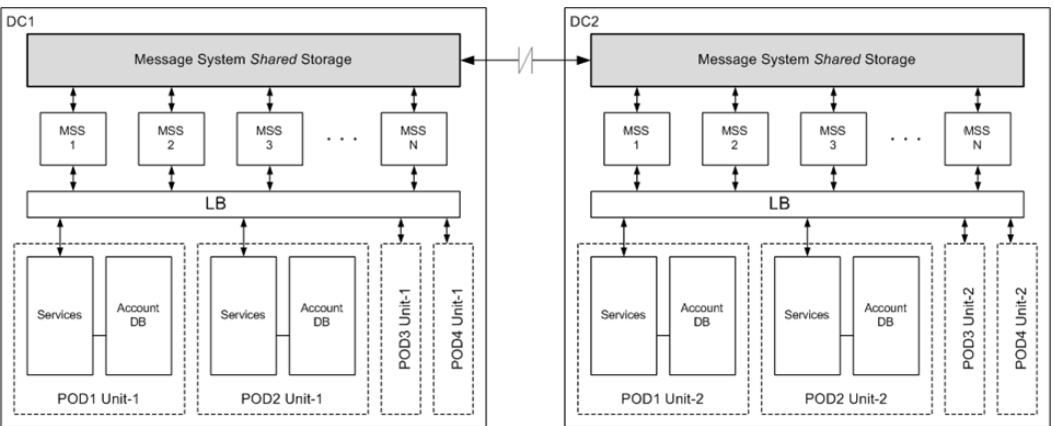
Figure 2. Example of regional GCC architecture with two data centers (DCs) [18].